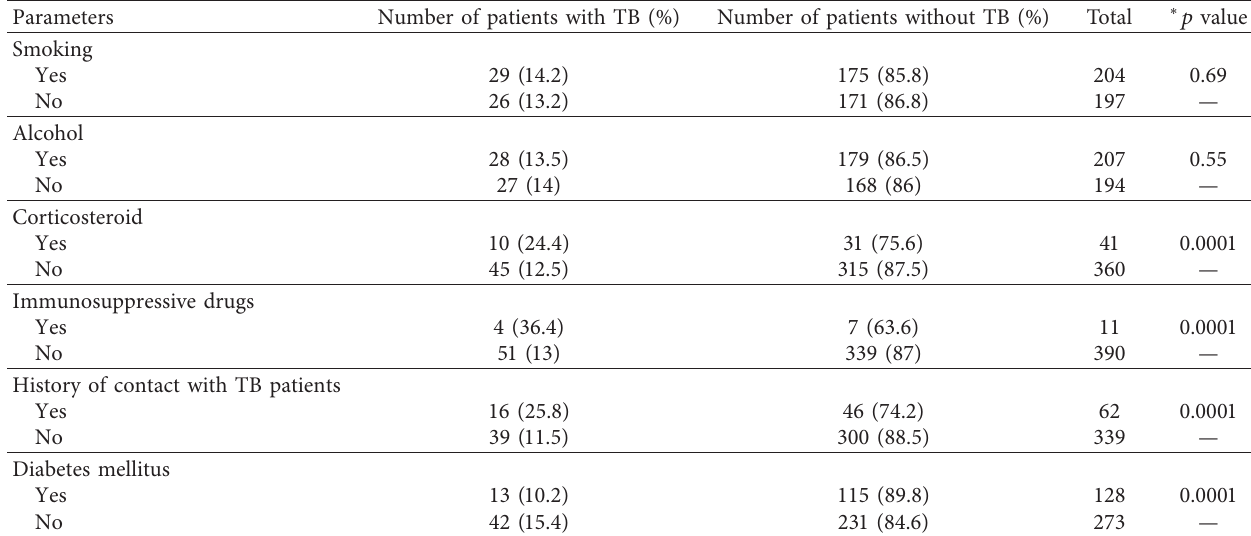
Table 5: Risk factors associated with tuberculosis.